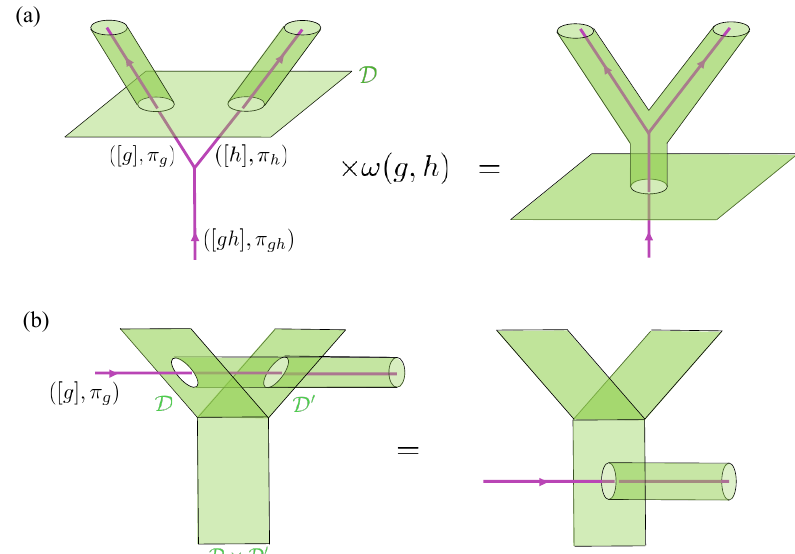
Figure 25: The U and η symbols for the automorphism ρ associated with the D (1 + 1)D G -SPT phase. (a): the symmetry action on the fusion vertex U is read D by crossing the defect through the junction of anyons. In the right figure after D crossing, the junction of the g , h ∈ G defects into gh is introduced on the SPT phase encircling the junction of the anyons. The Boltzmann weight of the SPT phase emits a phase ω ( g , h ) locally at this junction, which is regarded as the symmetry action on ′ ) describes the symmetry ( the vertex gauge transformation U . (b): η ([ , g ] , π g ) D D D ′ , which ) under the action of the defects fractionalization of the anyon ([ g ] , π , g D D ′ . Note ) through the junction of can be read by crossing the anyon ([ g ] , π and g D D that the whole process does not introduce the junction of gauge fields on the surface of SPT phase, so the SPT action does not produce any phase. We then conclude that ′ ) = η ( , ([ g ] , π ) D D g